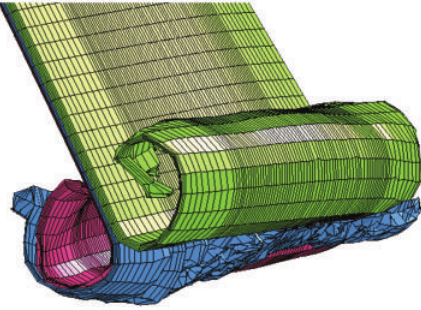
Figure 8: Simulation result at optimized point.